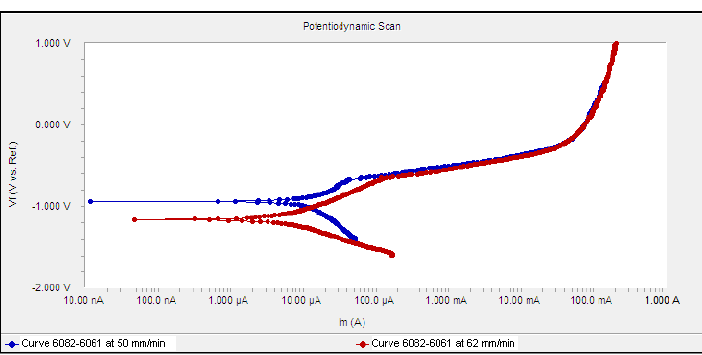
Figure 12: Polarization curves of AA6082-AA6061 at 50-62 mm/min.